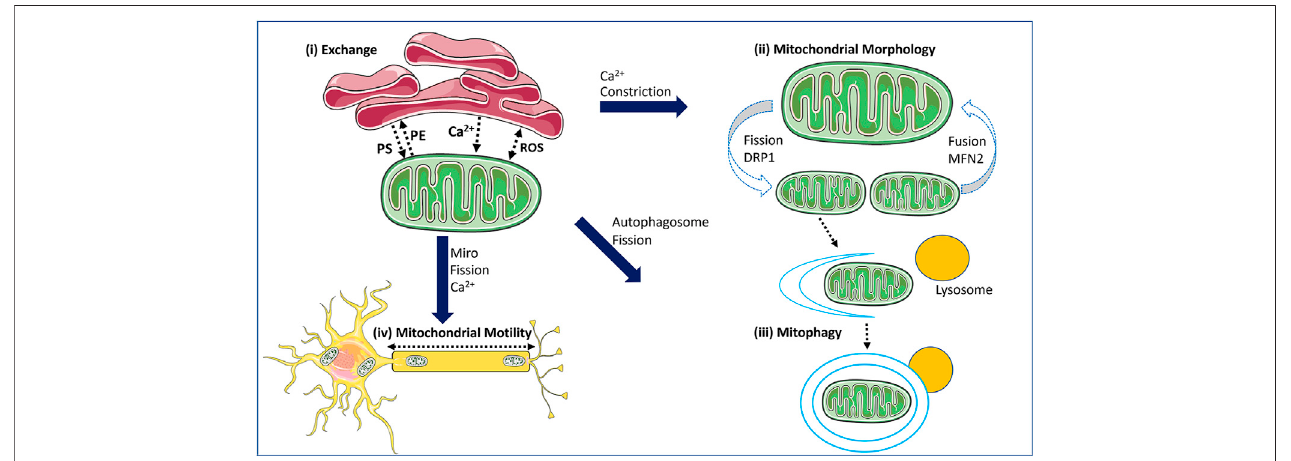
FIGURE 1 | The functions of MERCs within the cell. Mitochondrial-ER contact sites (MERCs) mediate several processes. (i) MERCs mediate the exchange of signalling molecules such as calcium (Ca 2+ ) and reactive oxygen species (ROS), as well as lipids. (ii) MERCs play a key role in regulating mitochondrial fi ssion and fusion, as they can mark sites where these events occur with the ER wrapping around mitochondrial tubules to initiate constriction, and via calcium. (iii) MERCs have functional ties to mitophagy, with recruitment of mitophagy factors and formation of the autophagosome occurring at MERCs. Mitophagy is also linked to mitochondrial fi ssion. (iv) MERCs impact mitochondrial motility, which requires fi ssion to generate mitochondrial fragments for transport, and via the mitochondrial transport proteins MIRO1/2 which are linked to MERC functions and are regulated by calcium. The schematics used in the fi gures were taken from Smart Servier (2021).